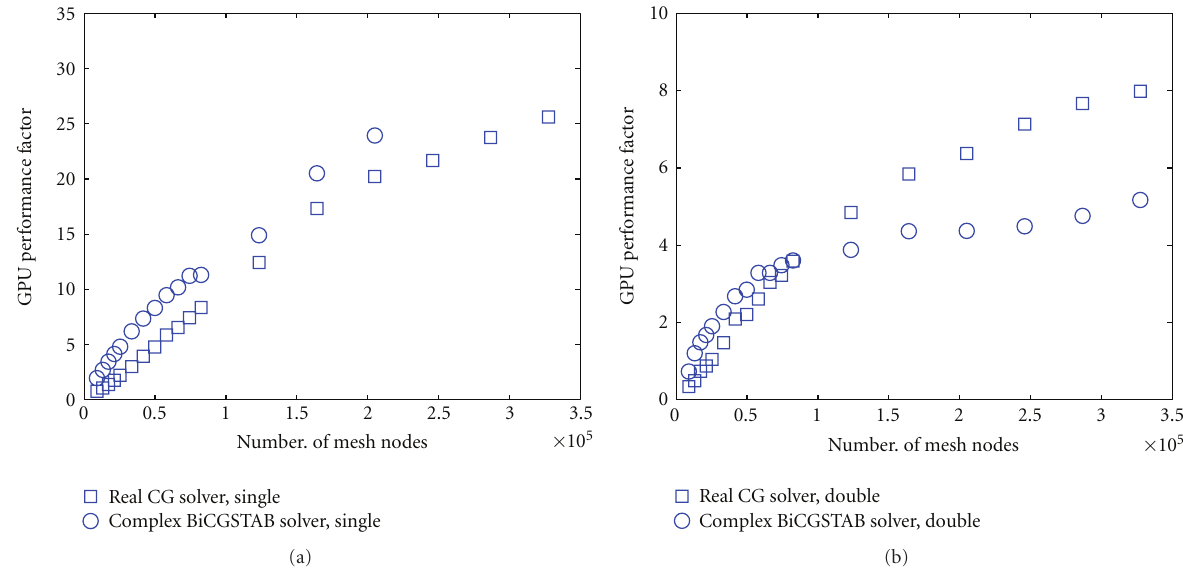
Figure 7: GPU performance factor as a function of mesh node count for a real-valued problem solved with preconditioned CG solver, and a complex-valued problem solved with preconditioned BiCGSTAB solver. (a): single-precision performance, (b): double-precision performance.